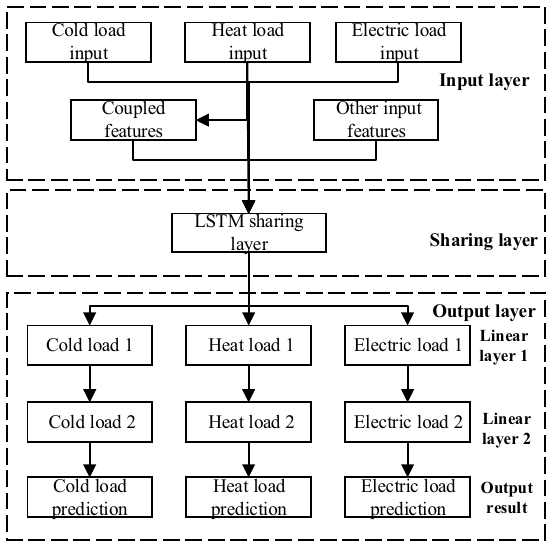
Fig. 1 LSTM-MTL model structure